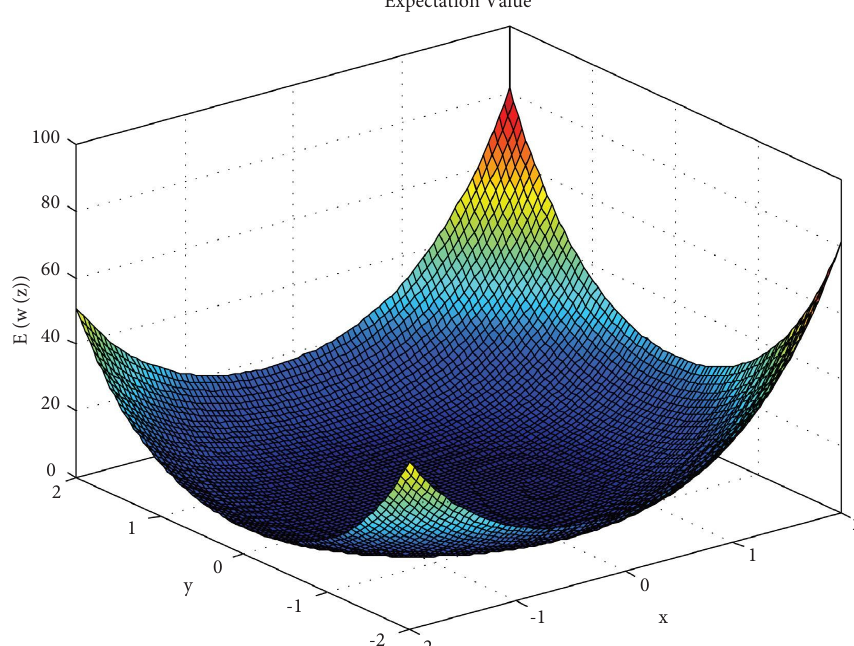
Figure 4: Expected value of equation (29) for μ � 1 , σ � 2.